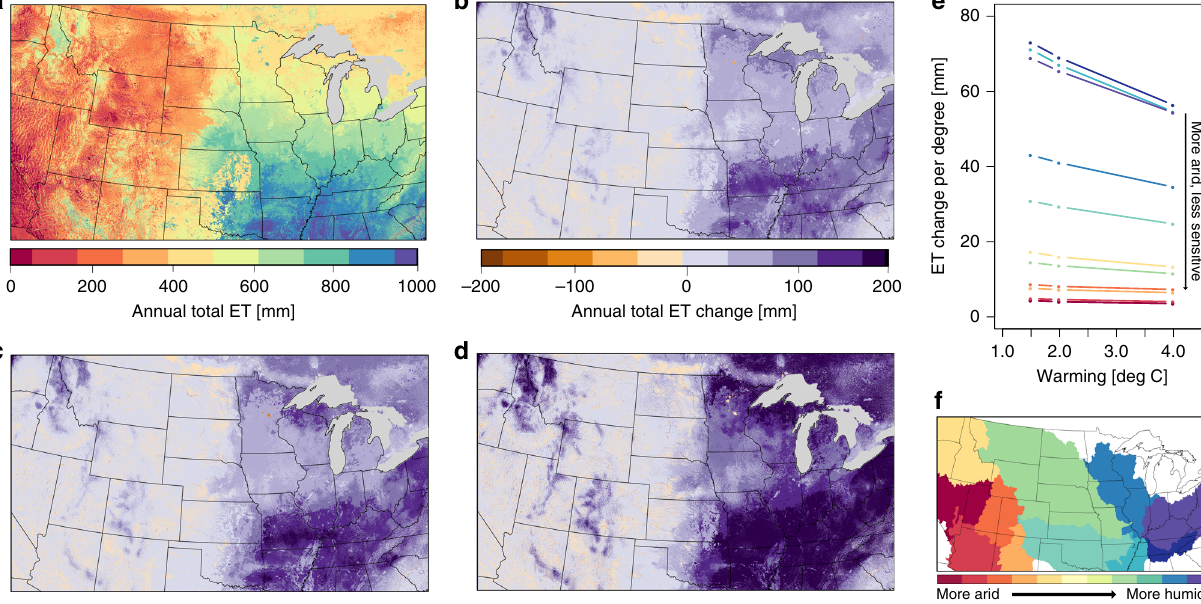
Fig. 3 Evapotranspiration is most sensitive to warming in the eastern US. a Map of Baseline annual evapotranspiration (ET) and the annual change in ET (warming – Baseline) for each of the warming scenarios; 1.5 °C ( b ), 2 °C ( c ), and 4 °C ( d ). All maps are for the fi nal year of simulation. Aggregated ET changes normalize by the degree of warming (Change in ET/degrees of warming) ( e ) are summarized by the major US watersheds in the domain colored by their rank with respect to average baseline aridity ( f